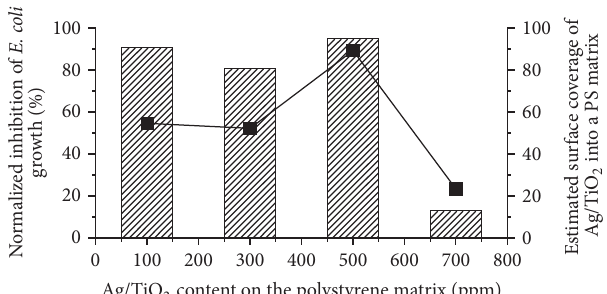
Figure 5: Antibacterial growth inhibition of polystyrene-based samples as Ag/TiO 2 concentration increases. Values are normalized with respect to a reference sample of pure polystyrene. Markers represent the estimated surface coverage of the Ag/TiO 2 . The inhibition of E. coli growth is directly related to the surface coverage of Ag/TiO 2 on the PS